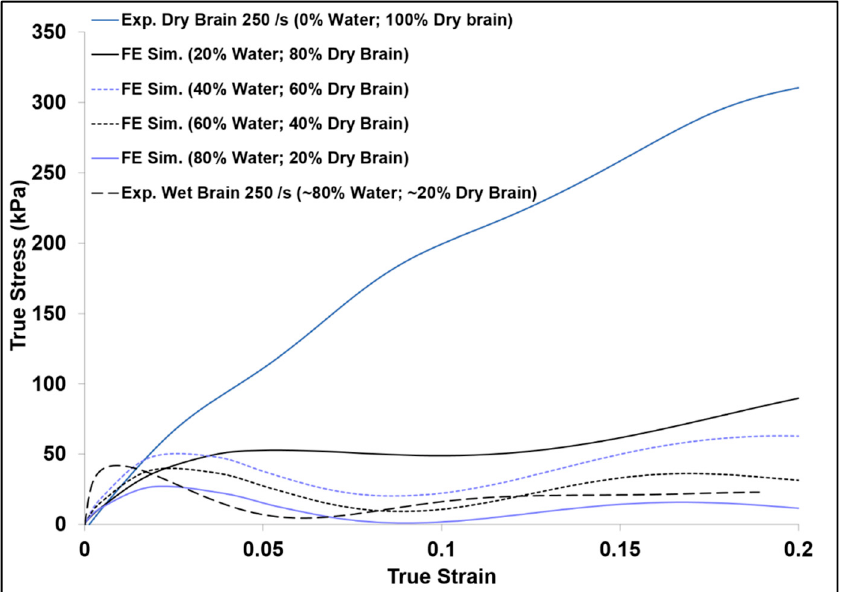
Figure 11. Comparison of finite element (FE) simulation and experimental true stress–strain ( σ 33 ) behavior of specimens with various water and dry brain m / m contents at a strain rate of 250 s − 1 . Here compressive stress and strain are taken as positive.